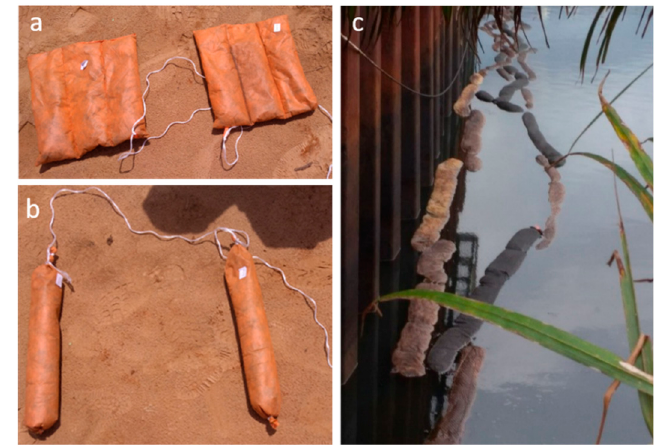
Figure 4. ( a ) Grafysorber ® pillows and ( b ) Grafysorber ® booms for American Petroleum Institute (API) oil-water separator test; ( c ) chains of Grafysorber ® and polypropylene (PP) booms in the channel. Table 2. Samples for tank tests.